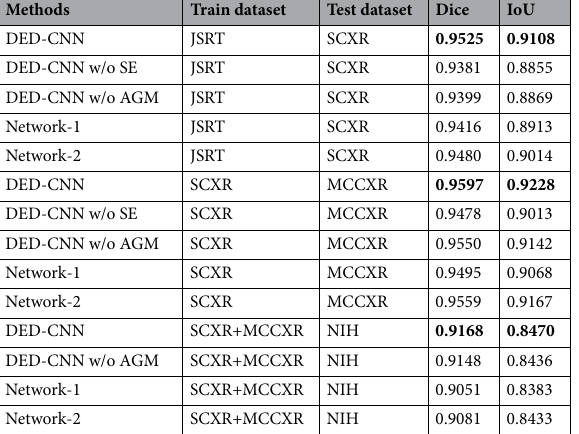
Table 6. Detailed comparison of the proposed method in the cross-dataset setting. The proposed method includes two encoder-decoder networks, referred to as Network-1 and Network-2, respectively. The bolded values represent the best